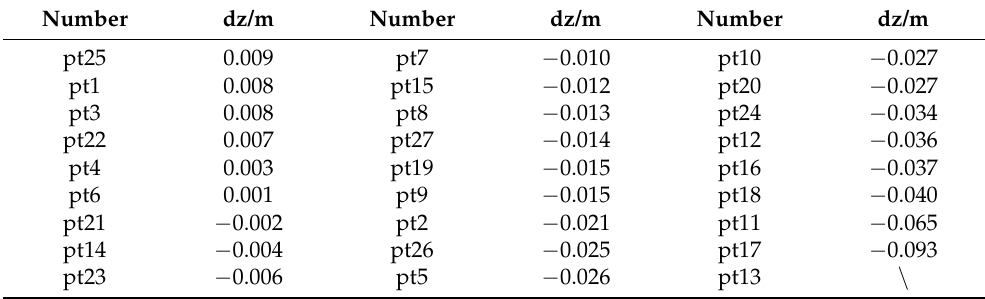
Table 3. The elevation difference between the point cloud and RTK control